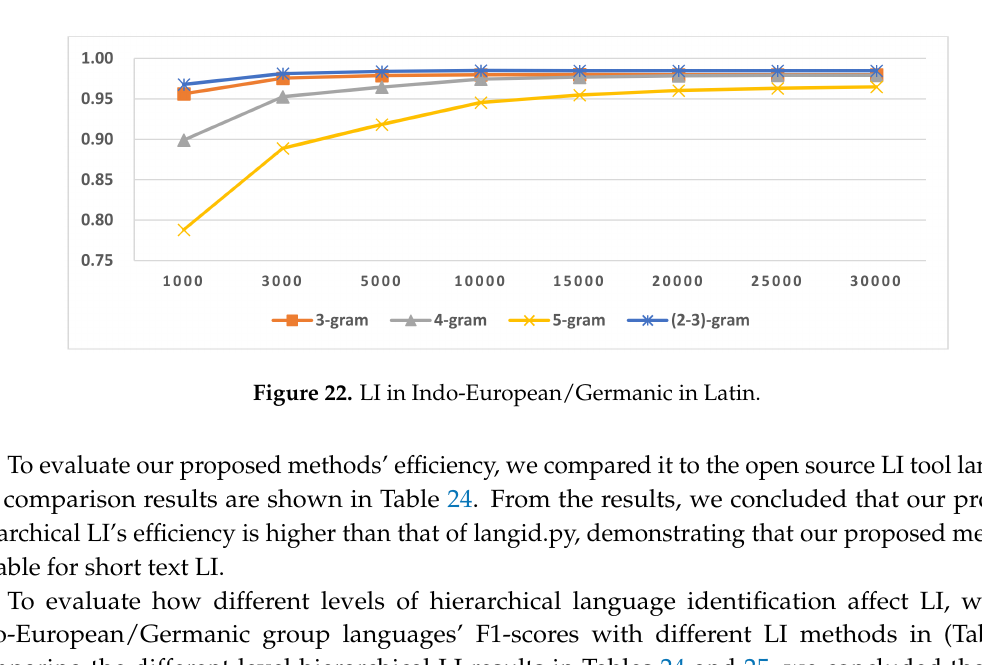
Figure 21. LI in Indo-European/Balto-Slavic in Latin.